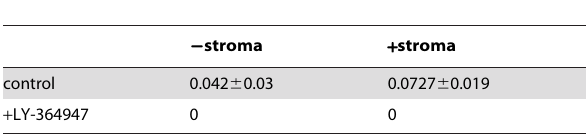
Table 3. Measurement of psmad2/3 and DAPI